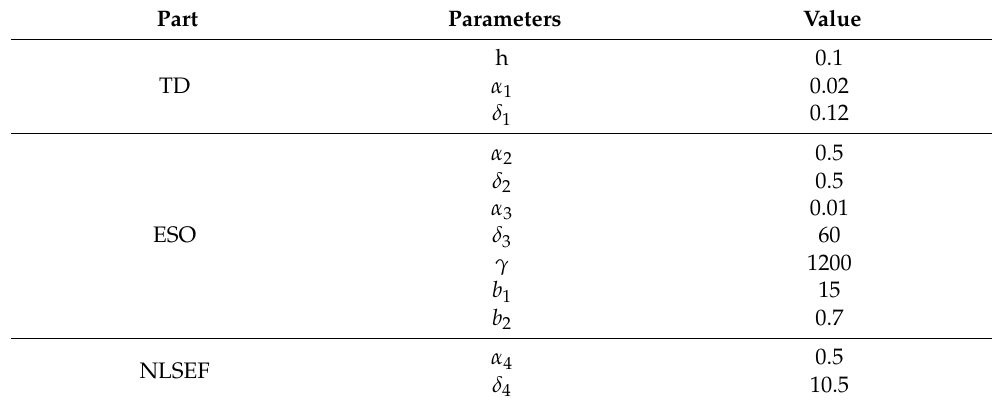
Table 2. Parameters of The ADRC.